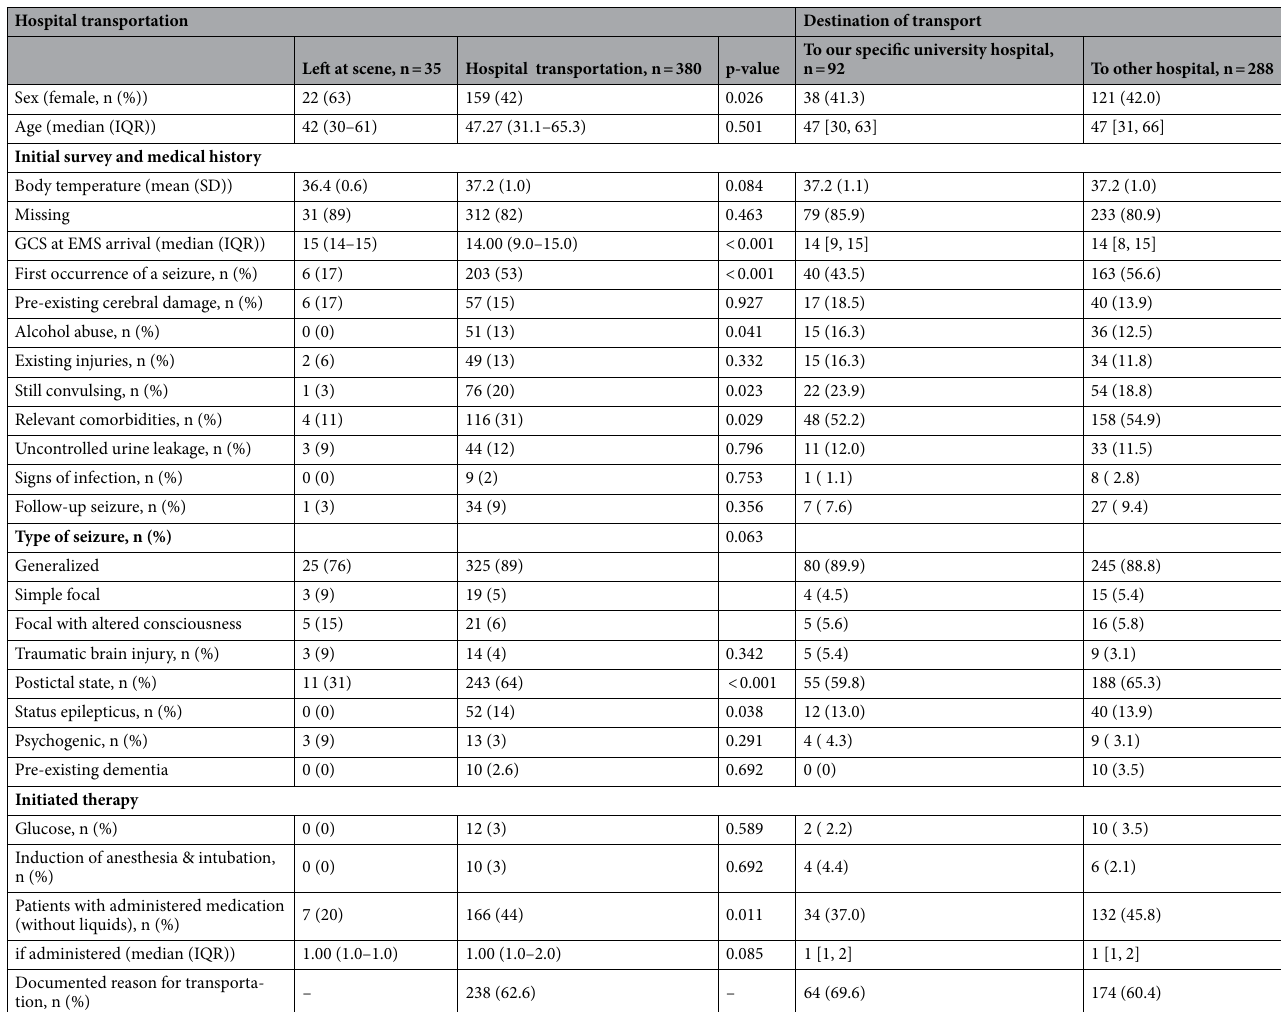
Table 3. Hospital transportation rates and potential influencing factors for all patients and stratified by hospital. Data are median and interquartile range or n. Reference for sex is female. “Pre-existing cerebral damage” includes brain tumor and metastases, intracranial hemorrhage and malformations as well as infantile brain damage and stroke; CI, Confidence Interval; Logistic regression was calculated for univariate significant variables for patients without substance abuse or without status epilepticus, odds-ratios and p values are presented. IQR Interquartile Range, GCS Glasgow-Coma-Scale, EMS Emergency Medical